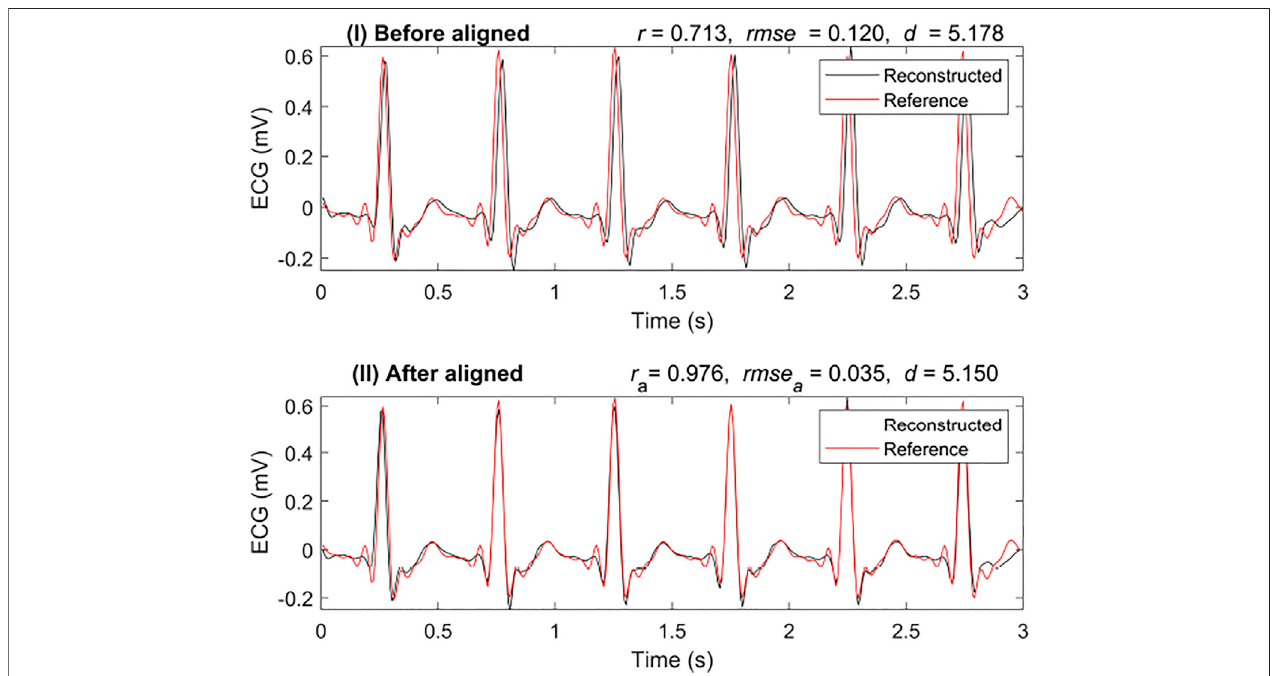
FIGURE4| ComparisonofreconstructionECGandreferenceECGwithandwithoutalignment.Theabbreviations r a , rmse a ,and d a arecalculatedafteraligningthe reconstruction ECG and reference ECG, respectively.